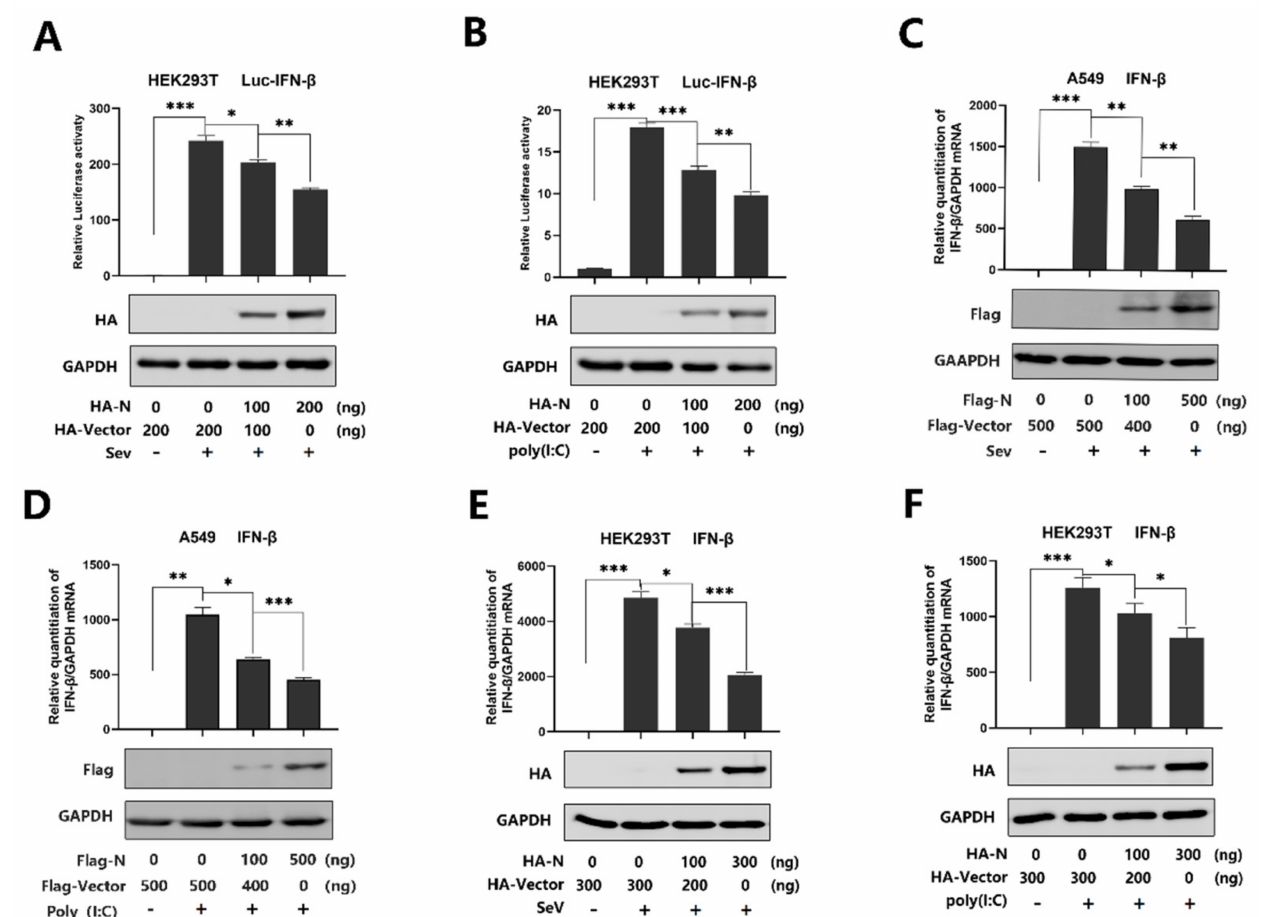
Figure 1. SARS-CoV-2 N protein represses IFN- β production induced by poly(I:C) and Sendai virus. ( A , B ) HEK293T cells were transfected with IFN- β luciferase reporter pIFN- β -Luc and pPRL-TK for 24 h and then infected with SeV (0.1 MOI) for 16 h ( A ) or transfected with cytoplasmic poly(I:C) (2 µ g/mL) for 16 h ( B ). Cell lysates were harvested, IFN- β -Luc reporter activity was determined by dual luciferase reporter assays (top), and HA-N was detected by Western blotting (bottom). ( C , D ) A549 cells were transfected with pFlag-N for 24 h and infected with SeV (MOI = 0.1) for 16 h ( C ) or transfected with poly(I:C) (1 µ g/mL) for 16 h ( D ). IFN- β mRNA was determined by q-PCR (top) and Flag-N was confirmed by Western blotting (bottom). ( E , F ) HEK293T cells were transfected with pHA-N for 24 h and infected with SeV (MOI = 0.1) for 16 h ( E ) or transfected with poly(I:C) (2 µ g/mL) for 16 h ( F ). IFN- β mRNA was determined by q-PCR (top) and HA-N was confirmed by Western blotting (bottom). Data in A–F were expressed as the mean ± SEM of at least three independent experiments. * p < 0.05, ** p < 0.01, *** p <